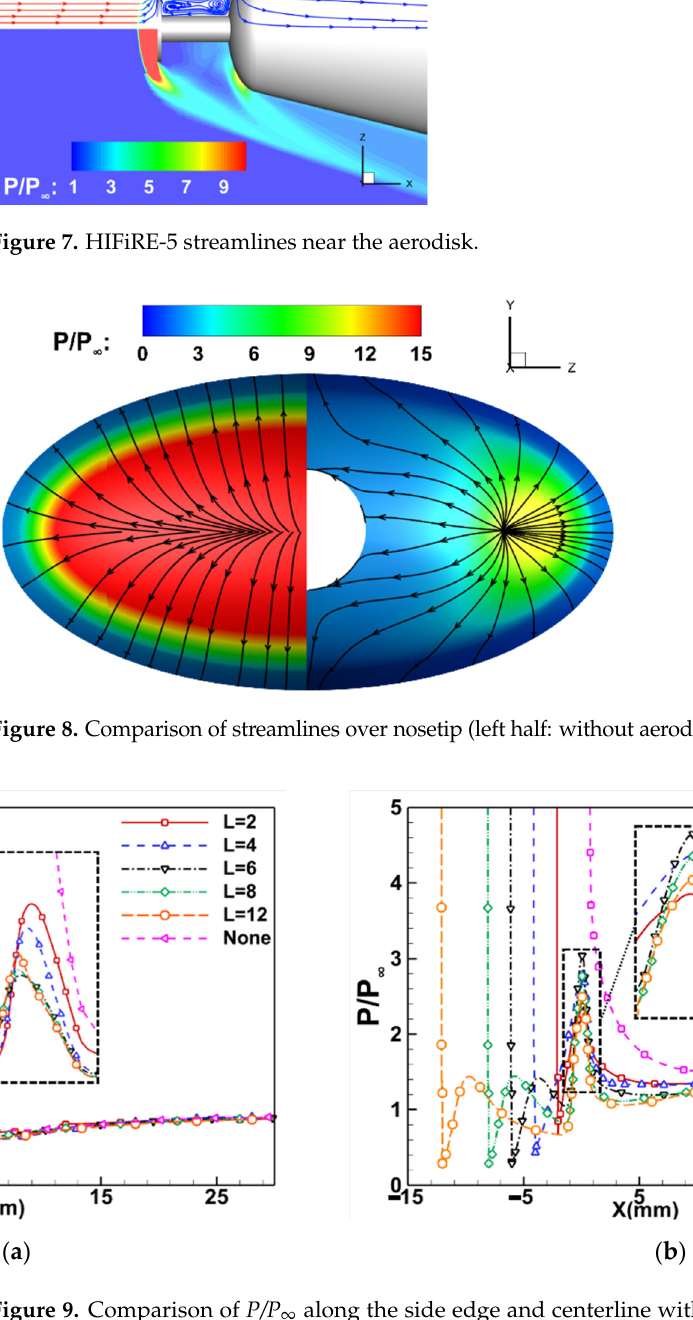
Figure 9. Comparison of P/P ∞ along the side edge and centerline with different aerodisk lengths. ( a ) along the side edge, ( b ) along centerline.